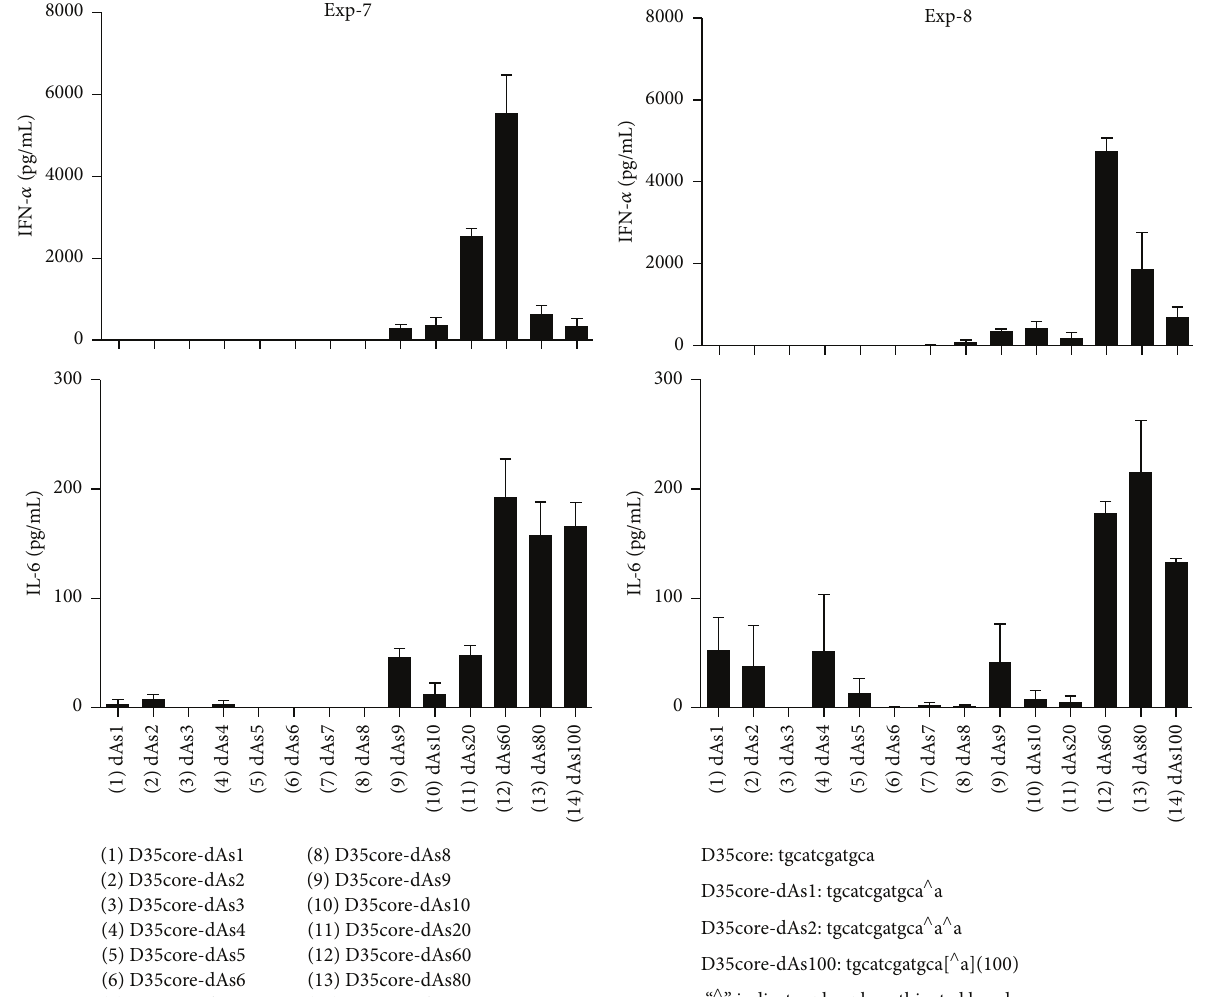
Figure 5: Length of the tail affects ODN’s immunostimulatory activities. Human PBMCs were stimulated with the indicated synthetic